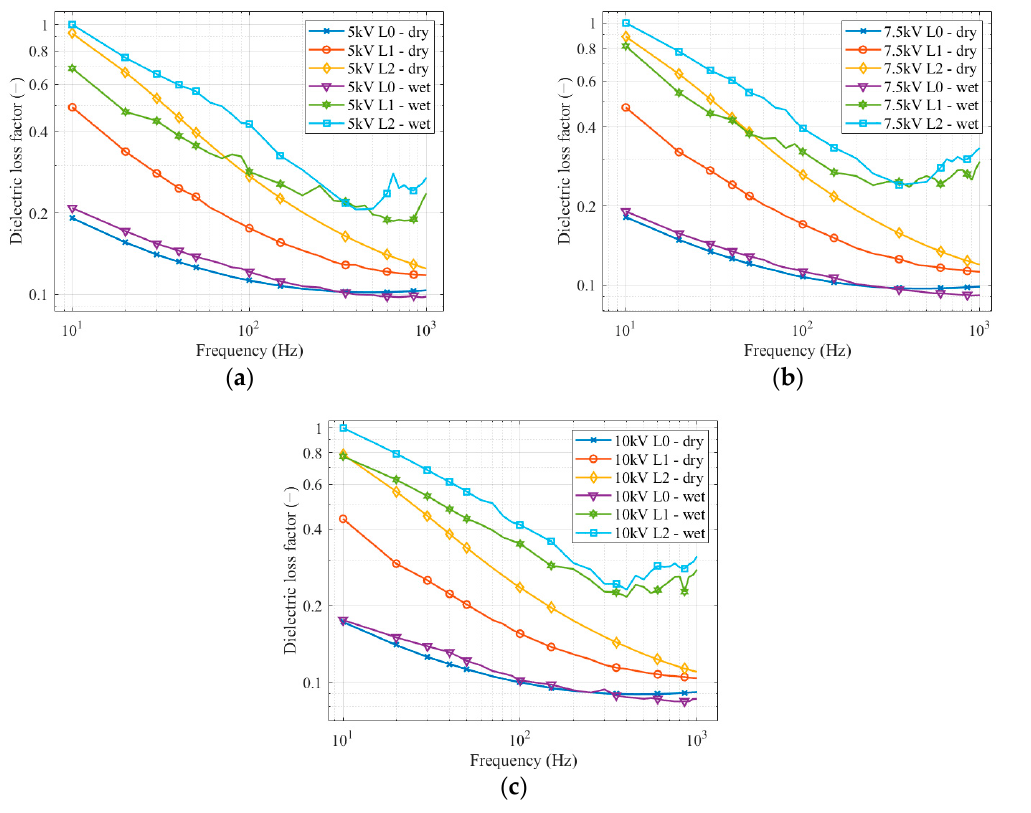
Figure 7. Dielectric loss factor frequency spectrum for a clean insulator and different pollution levels: ( a ) 5 kV; ( b ) 7.5 kV; ( c ) 10 kV. Table 4. The average difference between dielectric loss factors of different pollution levels and dif- ferent conditions.